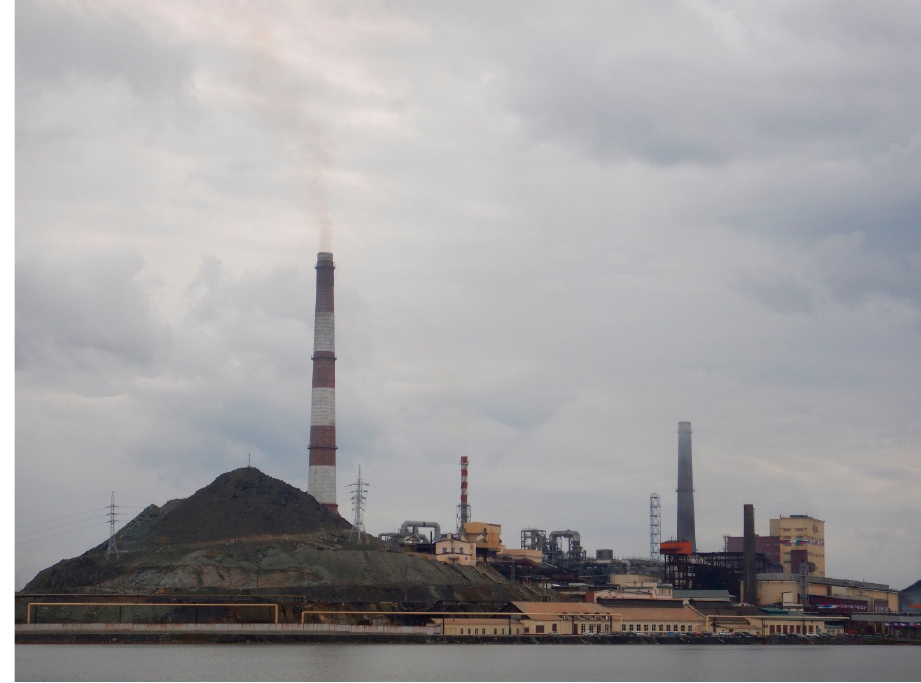
Figure 2. The view of Karabashskiy Copper-Smelting Plant (photo by the author). Similar trends of heavy metals (Cu, Zn, Pb, Sb, Cd) can also be seen in sediments of other lakes located in the impact area of Karabashskiy Copper-Smelting Plant [19,23]. For instance, this is well-demonstrated in the example of Lake Ufimskoe located 7 km from the plant (Figure 3). The uppermost layers of lake sediments are enriched with Cu (up to 2341 mg/kg while the background level is ~120 mg/kg), Zn (up to 1256 mg/kg, background is ~54), Pb (up to 1039 mg/kg, background is ~8), Sb (up to 21 mg/kg, background is ~0.3), and Cd (up to 13 mg/kg, background is ~0.4) [19]. These metals are closely related to the copper-smelting plant operations. Other elements (e.g., V, Co, Li, rare earth elements, etc.) did not have a similar tendency towards an increase in the upper layers compared to the lower ones, which indicates that their origin in sediments is not related to the anthropo- genic impact on the water body [19]. Figure 3. The vertical distribution of heavy metals in sediments of Lake Ufimskoe (Chelyabinsk Region) [19].